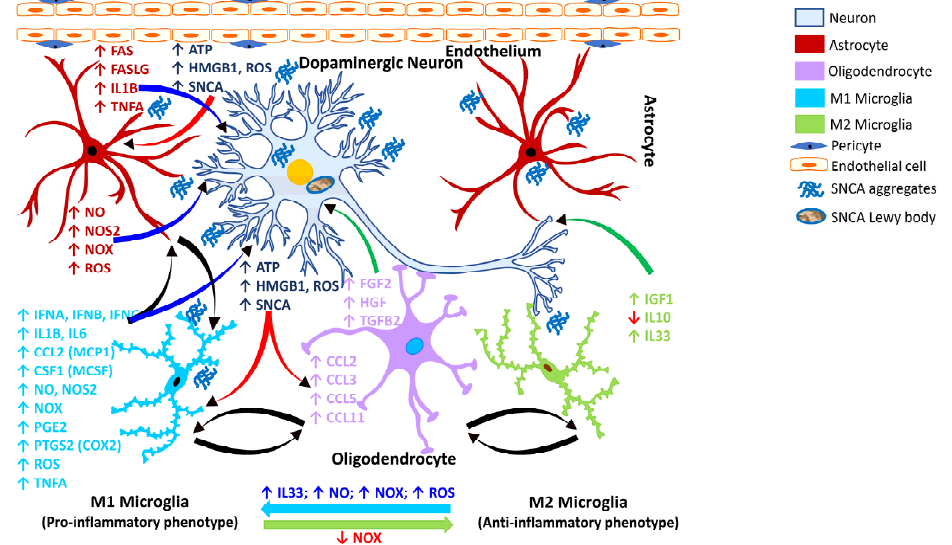
Figure 3. Inflammatory cascade in Parkinson’s disease. Schematic representation of the molecular mechanisms associated with glia-mediated functional interactions and systematic perturbations within the CNS to induce neuroinflammation in Parkinson’s disease. The endothelial cells form the inner lining of the blood vessel with pericytes enveloping the surface of the vasculature forming tight junctions to maintain the BBB integrity. Upon insult, the augmented production and release, as well as impaired clearance of α SYN (SNCA) sustains chronic activation of the primed microglia resulting in the production and release of proinflammatory mediators including free radicals, cytokines and chemokines, thereby affecting the resident CNS cells (astrocytes, oligodendrocytes, and neurons) and leading to α SYN (SNCA) aggregation, neuronal injury and Lewy body formation. M1 microglia (proinflammatory phenotype, neurotoxic) release various proinflammatory mediators, including free radicals, cytokines, and chemokines that further stimulate other glial cells and collectively contribute to exacerbating neuronal injury/damage. M2 microglial cells (anti ‐ inflammatory phenotype, neuroprotective) can polarize to an M1 state and release proinflammatory mediators in the presence of increased levels of NOX, ROS, NO, and IL33 released by M1 microglia and/or astro ‐ cytes and thereby augment the neuroinflammatory and neuronal injury process leading to synaptic dysfunction, neuronal injury, and neuronal death. Astrocytes respond by releasing proinflamma ‐ tory mediators, including free radicals, cytokines, and chemokines, which further contribute to en ‐ hancing endothelial permeability, disrupting BBB integrity, and allowing for infiltration of periph ‐ eral immune cells, events that further intensify inflammation and neuronal injury. Feedback regu ‐ lation of NOX or its inhibition causes M1 microglia to polarize to the M2 state (anti ‐ inflammatory phenotype), which downregulates M1 functions and promotes regulation of neuroinflammation and neurorepair by releasing anti ‐ inflammatory mediators such as cytokines, neurotrophic, and growth factors. Mediators released by specific neural cell types (neuron, astrocyte, microglia, or ol ‐ igodendrocyte) are listed adjacent to each cell type in similar colored text. Curved arrows indicate the direction of signal flow between various neural cells for the inflammation activation process. Red curved arrows show the directional flow of danger/damage signals from neurons to glial cells (astroglia, microglia, oligodendroglia); blue curved arrows show the flow of proinflammatory sig ‐ nals from astrocytes and M1 microglia towards distressed neurons; green curved arrows show the flow of neurotrophic signals from M2 microglia and oligodendroglia towards the distressed neu ‐ rons as a neuroprotective/neurorescue endeavor; black curved arrows show the directional crosstalk among various glial cells to mount a glial response to neuronal injury/damage. ↑ , increase; ↓ , de ‐ crease; ATP, adenosine triphosphate; BBB, blood ‐ brain barrier; CCL2, C ‐ C motif chemokine ligand 2 (also referred to as MCP1, monocyte chemoattractant protein 1); CCL3, C ‐ C motif chemokine lig ‐ and 3; CCL5, C ‐ C motif chemokine ligand 5; CCL11, C ‐ C motif chemokine ligand 11; CSF1, colony ‐ stimulating factor 1; FAS, Fas cell surface death receptor; FASLG, Fas ligand; FGF2, fibroblast growth factor 2; HGF, hepatocyte growth factor; HMGB1, high ‐ mobility group box 1; IFNA, inter ‐ feron alpha; IFNB, interferon beta; IFNG, interferon gamma; IGF1, insulin ‐ like growth factor 1; IL1B,